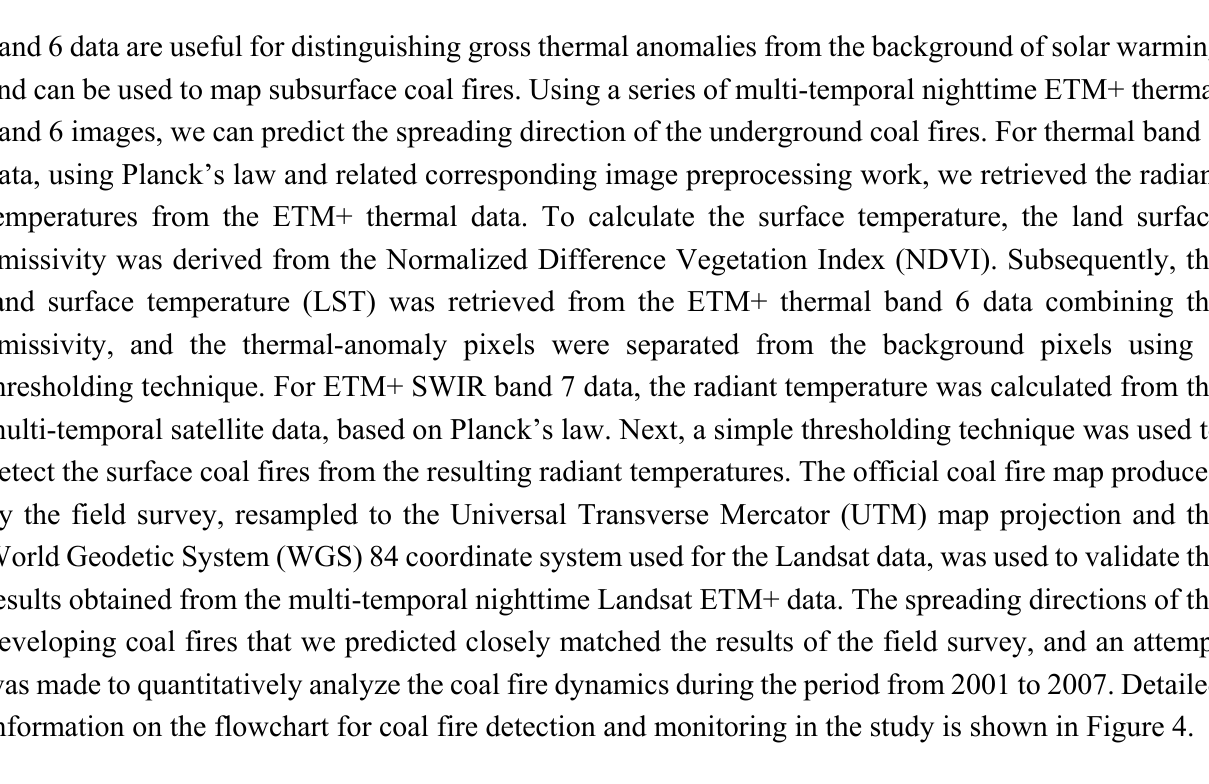
Figure 4. Flowchart of coal fire detection and monitoring in the